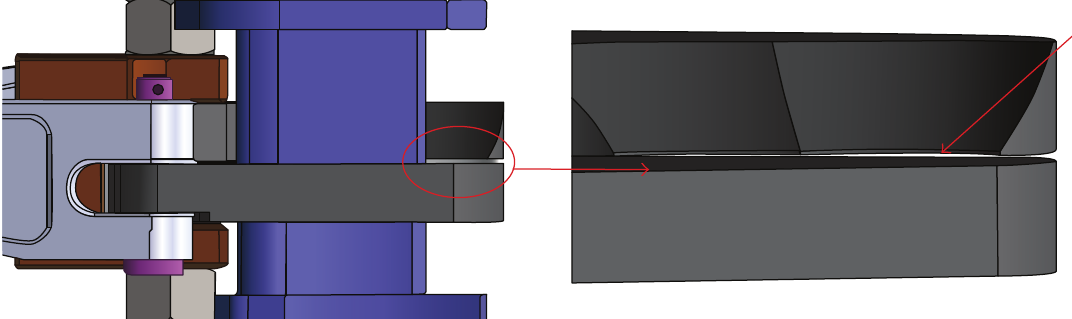
Figure 10: Clearance between the two